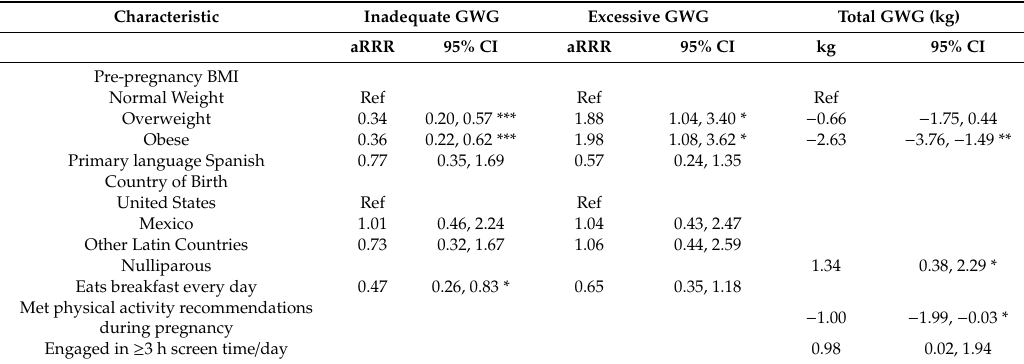
Table 4. Multivariable multinomial logistic regression and multivariable linear regression estimating associations of gestational weight gain with sociodemographic characteristics and health behaviors ( n =